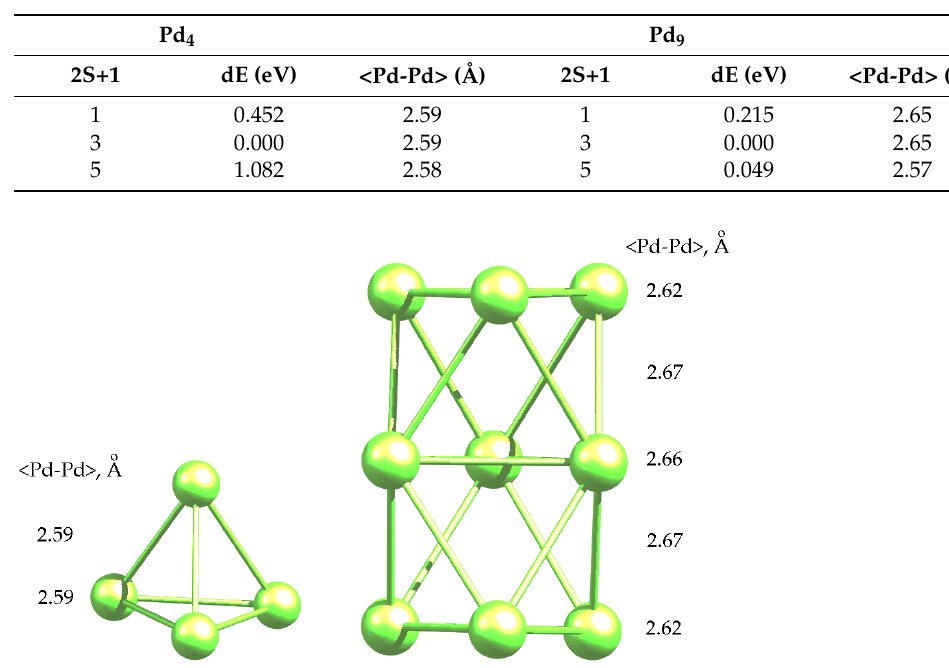
Table 1. Results of geometry and relative energy calculations for Pd 4 and Pd 9 .